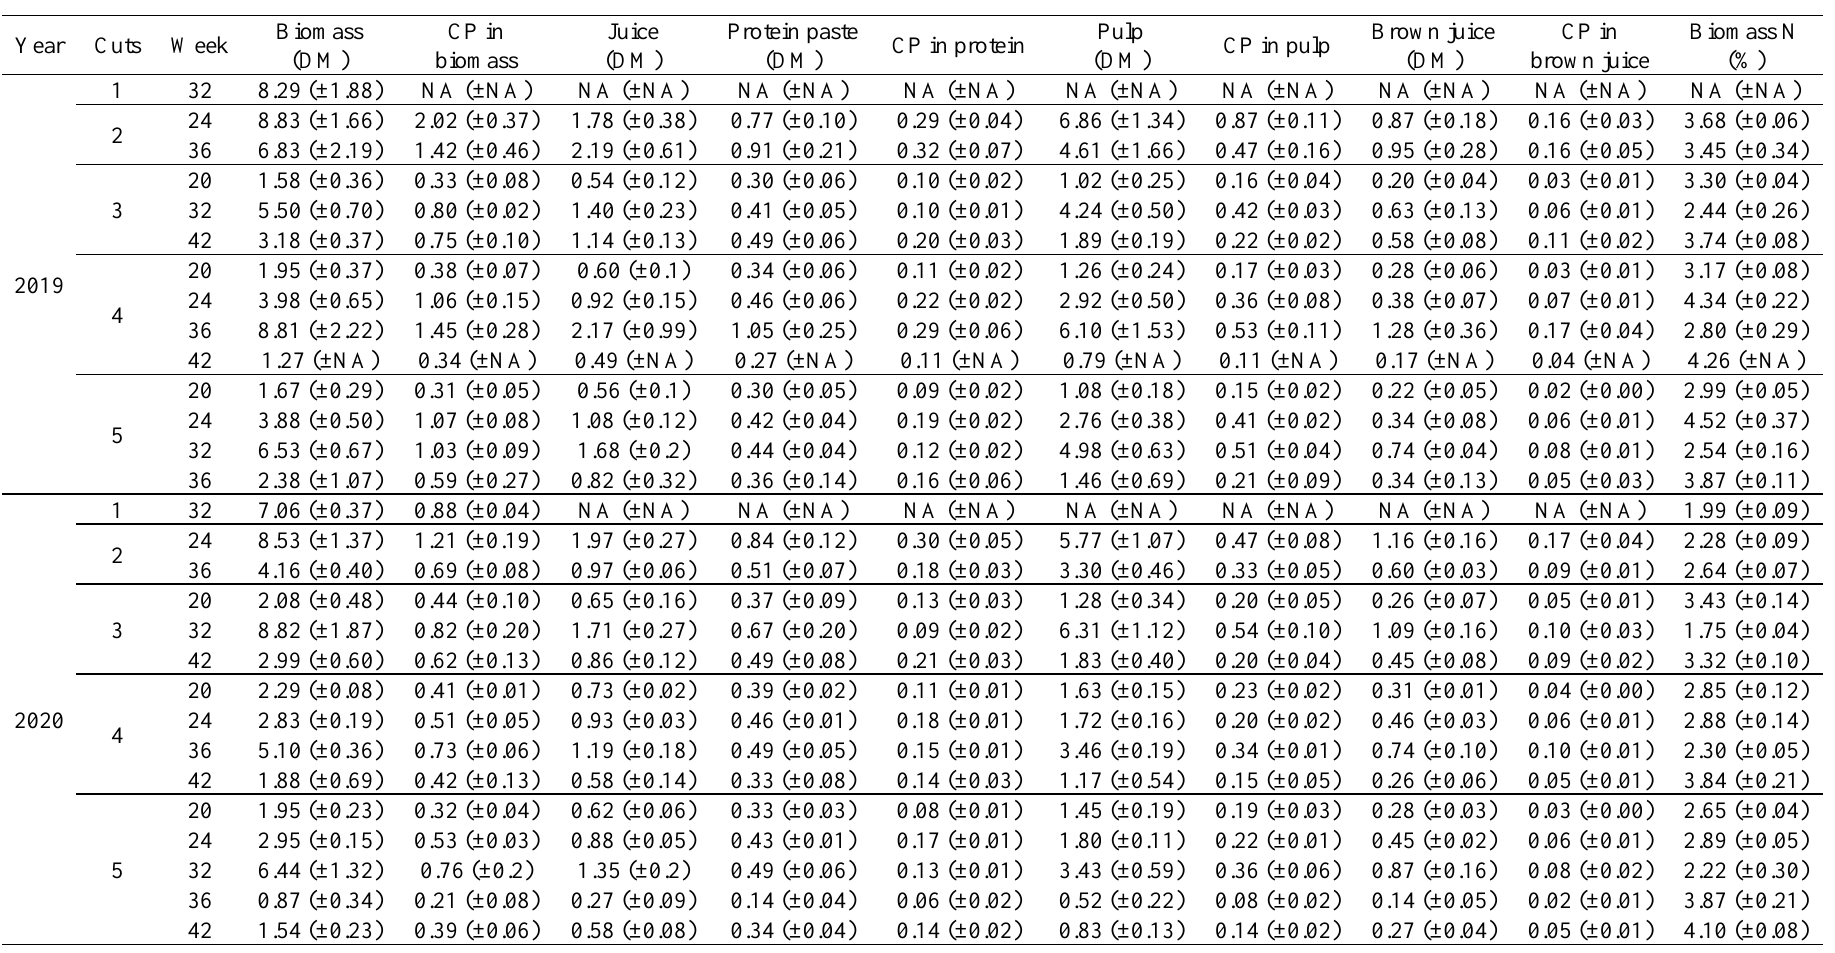
Table A1. Average yields for biomass and all fractions resulting from green biorefinery, including the respective crude protein (CP) yields, for Phalaris arundinacea (RCG) under harvest frequencies of one to five annual cuts, for each harvest occurrence as indicated by calendar week and for both assessed years. Standard error is given in brackets. All values are expressed in t ha -1 yr -1 (DM or CP) except for nitrogen (N) (%). Missing data (NA = not available) could not be determined due to technical difficulties. Values for 2019 are taken from Nielsen et al .